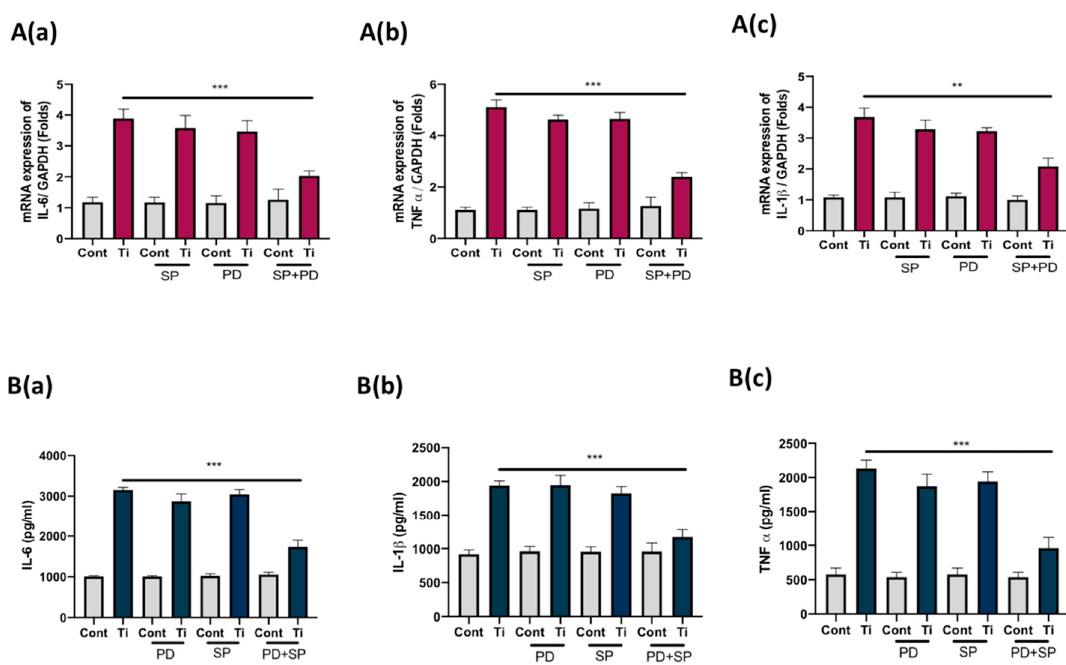
Figure 4. Co-inhibition of ERK and JNK MAPKs suppresses the expression of pro-inflammatory cytokines in SW982 cell line. Ti particles were used to treat (Cell-to-particle ratio of 1:100) SW982 cells prior to incubation (30 min) with either PD98059 (5 µ M), SP600125 (5 µ M), or PD98059 along with SP600125 for 24 h. RT-PCR analysis showing the mRNA expression of ( A(a) ) IL-6, ( A(b) ) IL-1 β , and ( A(c) ) TNF α after co-inhibition of ERK and JNK MAPKs. The mRNA expression of each targeted gene was normalized to GAPDH. ( B ) ELISA results demonstrated secretion levels of ( B(a) ) IL-6, ( B(b) ) IL-1 β , and ( B(c) ) TNF α after co-inhibition of ERK and JNK MAPKs. The results are presented as means ± SDs of three independent experiments. In the graphical representations, ** p < 0.01 and *** p < 0.001 indicate significant differences from the control group.